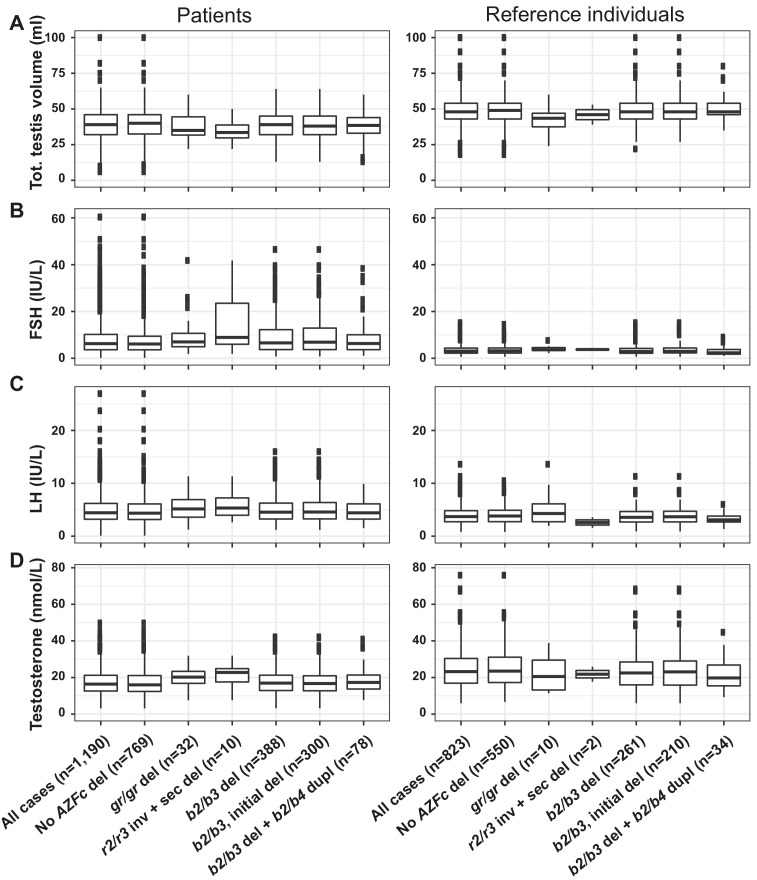
Distribution of hormonal and testicular parameters in idiopathic male factor infertility cases with spermatogenic impairment and reference individuals.(A) Total testis volume, (B) FSH, (C) LH and (D) testosterone. Samples are grouped by genotype with the number of samples (n) shown in brackets. Del, deletion; sec, secondary; inv, inversion; dupl, duplication.